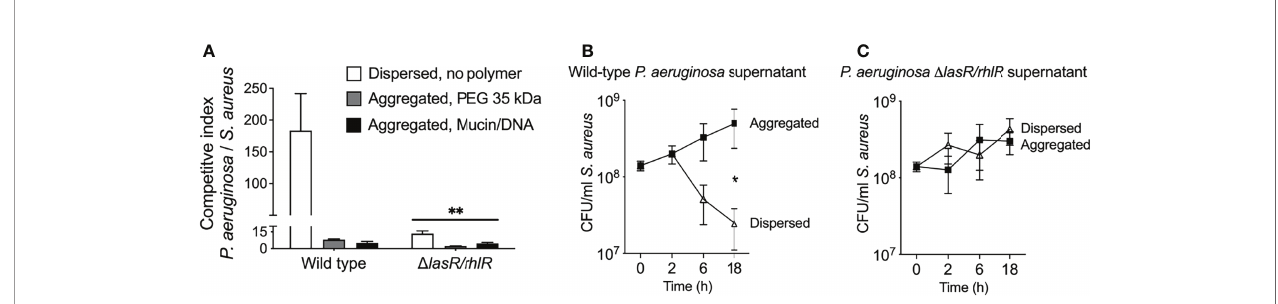
FIGURE 5 | Depletion aggregation increases S. aureus tolerance to quorum-regulated antimicrobials secreted by P. aeruginosa . (A) Equal numbers (10 7 CFUs) of S. aureus and P. aeruginosa (wild-type PAO1 or D lasR/rhlR ) were cocultured in LB supplemented with 30% w/vol PEG 35 kDa or mucin (4%w/vol) and DNA (2 mg/ml), where indicated. After 18-h, viable bacteria were enumerated by serial dilution and plating and plotting the competitive index (change [ fi nal/initial] in P. aeruginosa vs. S. aureus CFUs). Results are the mean ± SD, N = 3 for each condition; **p<0.01 relative to wild type, Student ’ s t -test. (B, C) S. aureus (10 8 CFU/ml) was added to fi lter sterilized supernatants collected from wild-type or D lasR/rhlR P. aeruginosa overnight cultures supplemented with 30% w/vol PEG 35 kDa where indicated. Viable S. aureus was enumerated by serial dilution and plating at the indicated times. Results are the mean ± SD, N = 3 for each condition and timepoint; *p < 0.02, Student ’ s t